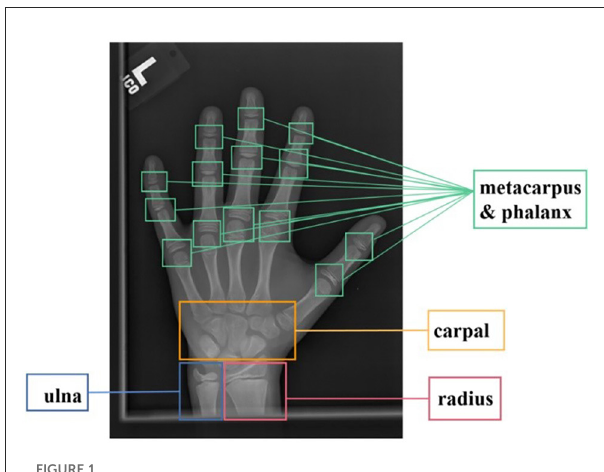
FIGURE1 ROIs of bone X-ray images for bone age